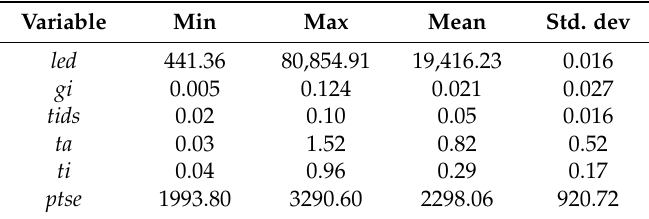
Table 8. Descriptive statistics of conditional variables.